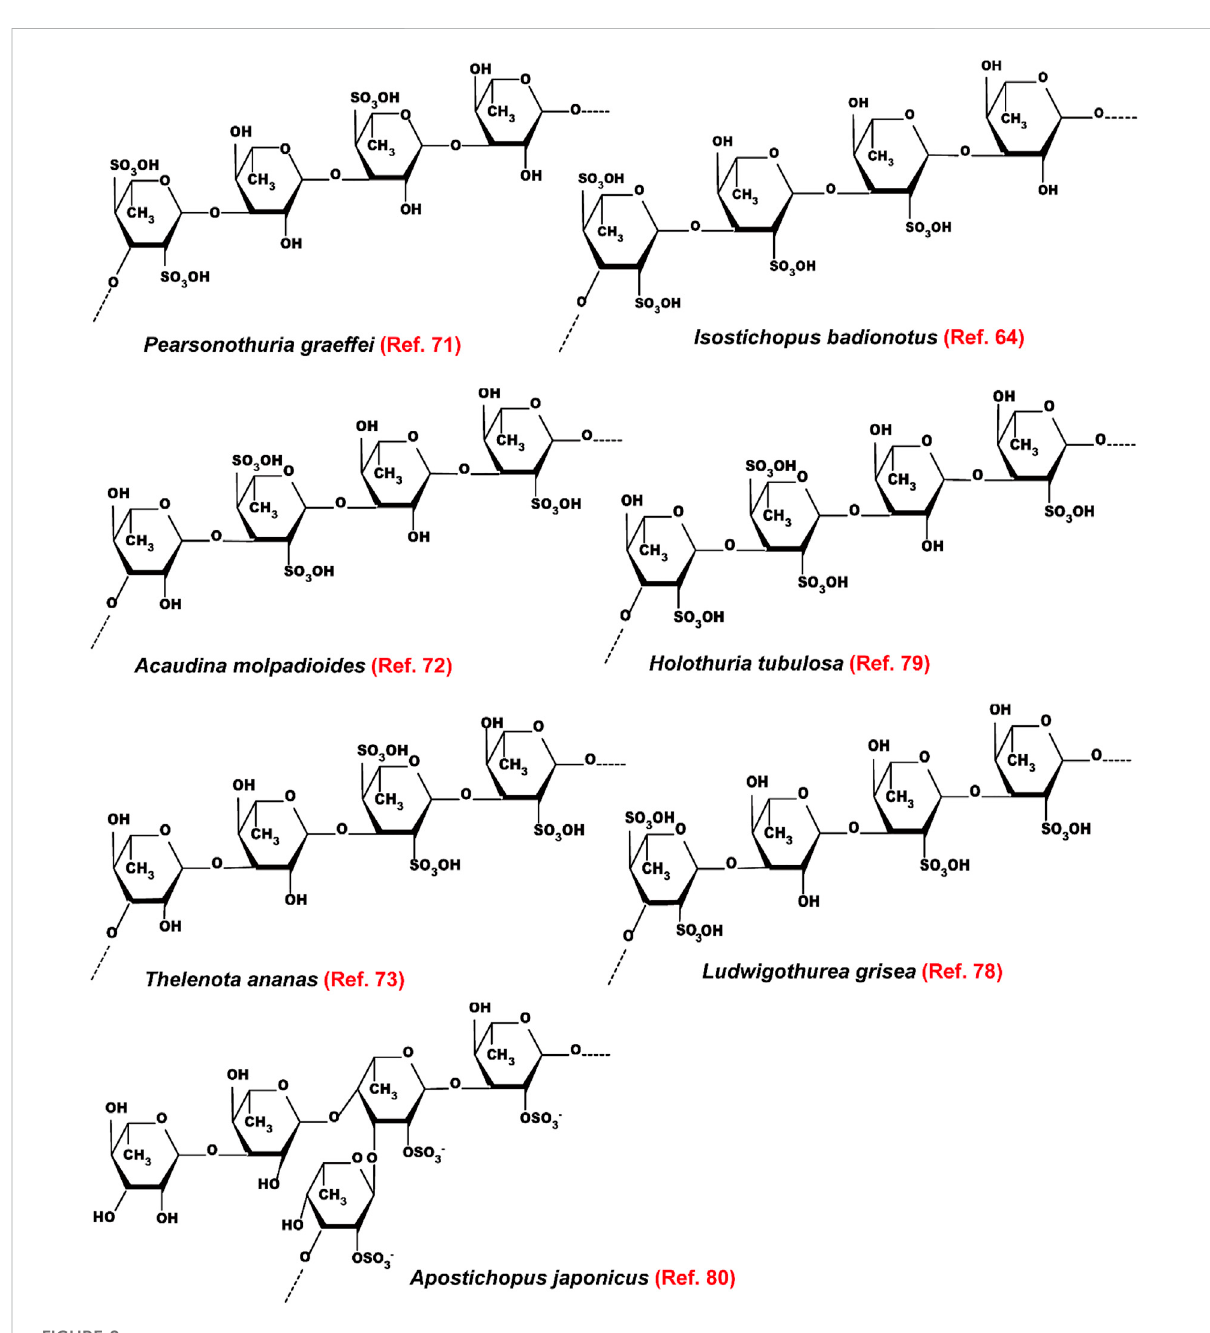
FIGURE 8 The structure of fucoidans extracted from different sea